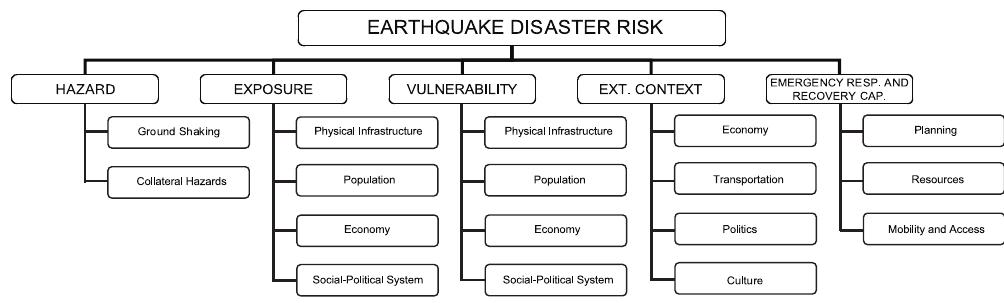
Fig. 1. Factors contributing to the definition of earthquake disaster risk (after Davidson,